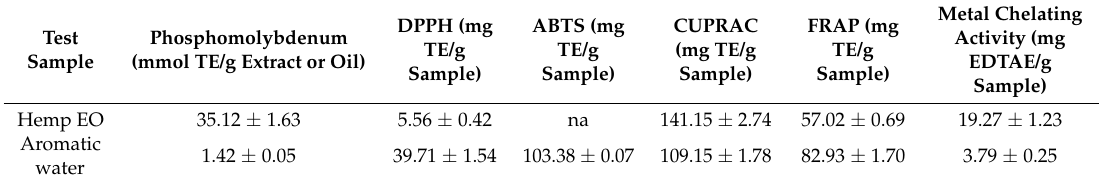
Table 5. Antioxidant properties * of the C. sativa